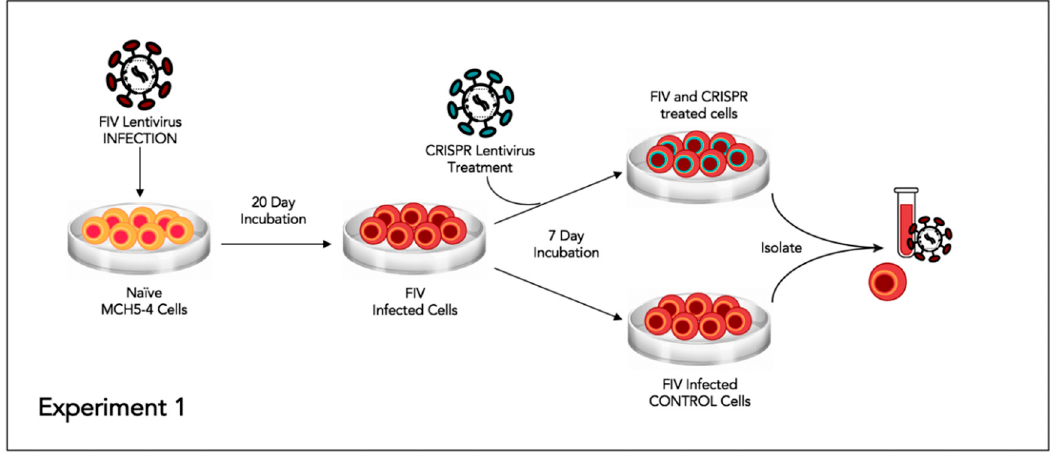
Figure 4. Schematic diagram of Experiment 1.